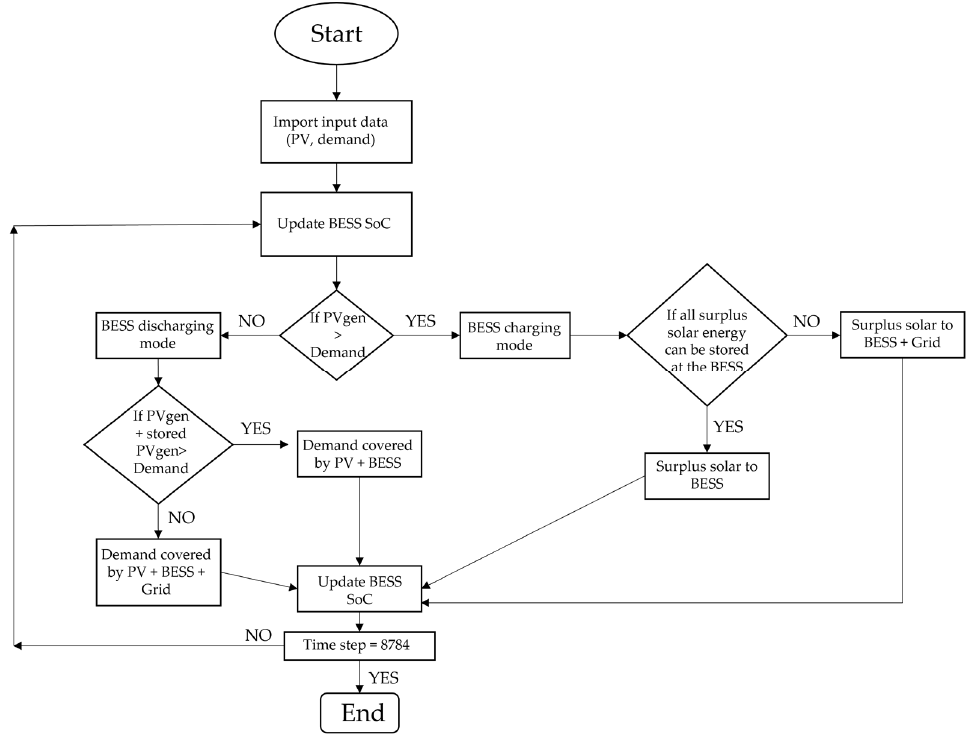
Figure 4. Flow chart of the energy management algorithm developed for scenario 2.